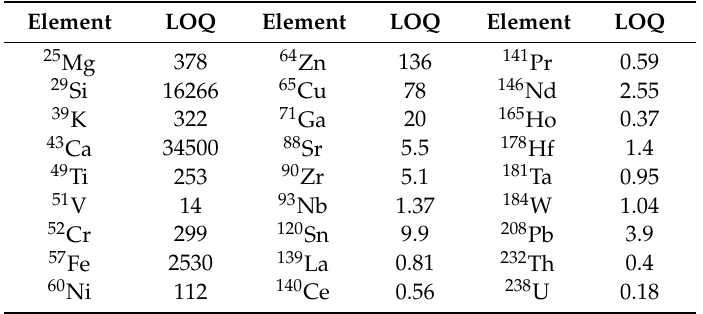
Table 2. Median limits of quantification (LOQ − 3 × LOD) obtained for 26 elements in ppb. Element LOQ Element LOQ Element LOQ 25 Mg 378 64